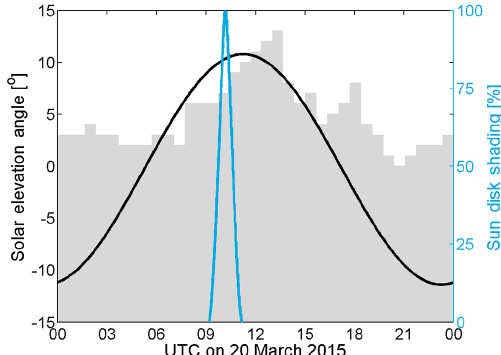
Figure 1. Solar elevation angle (black line) for Ny-Ålesund coor- dinates (78.9 ◦ N, 11.9 ◦ E) on 20 March 2015, with local horizon- tal line (grey shading). The totality of the solar eclipse is indicated (cyan line).